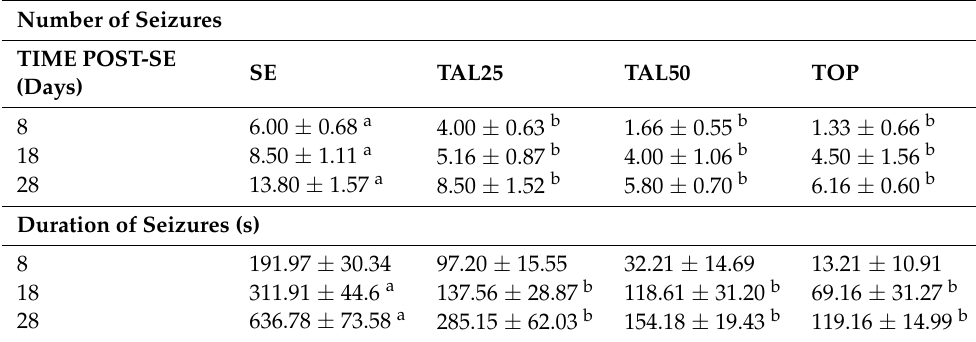
Table 1. Effect of thalidomide and topiramate on the number and duration of spontaneous recurrent seizures (SRS) observed 8, 18 and 28 days after